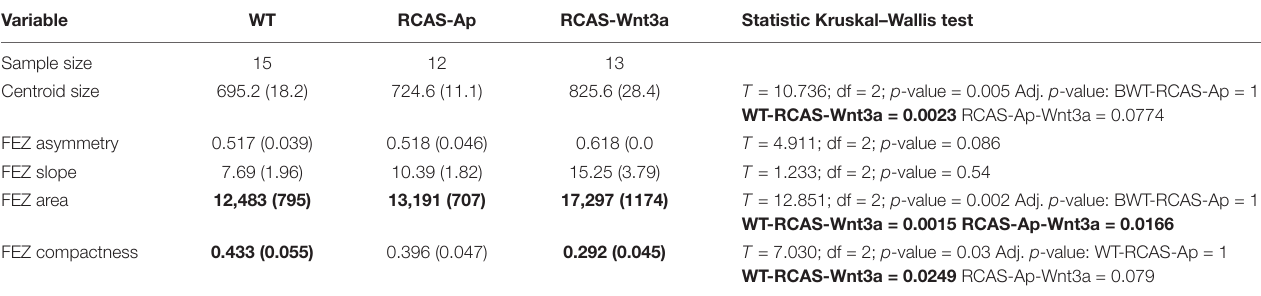
TABLE 1 | Kruskal–Wallis test for the frontonasal ectoderm zone (FEZ) and head size (centroid size). Variable